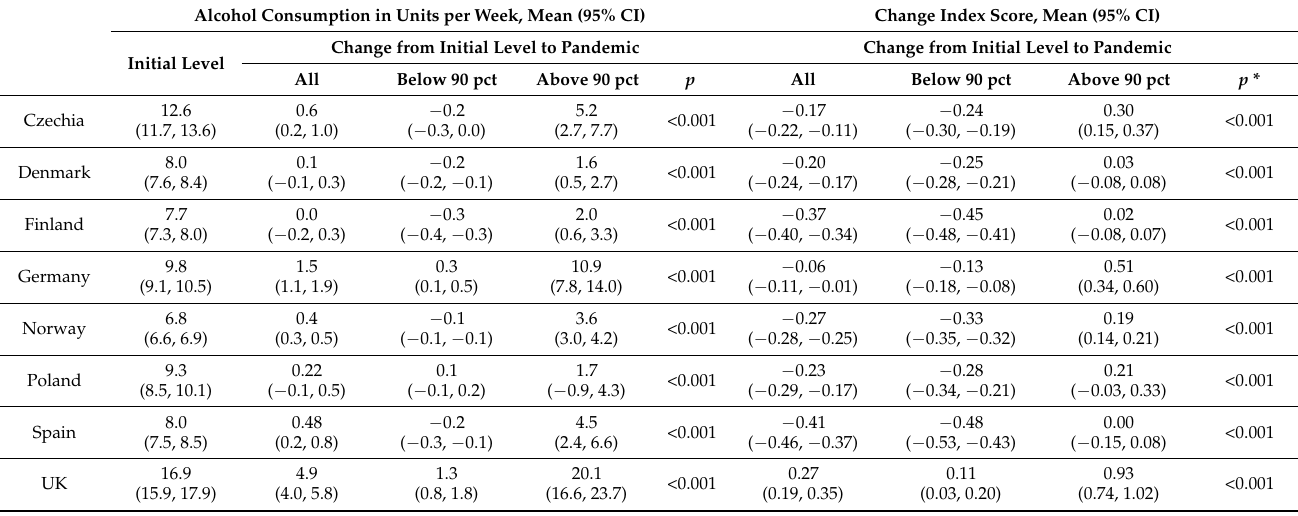
Table 2. Initial consumption, change in alcohol consumption for all and by initial consumption level (below vs. above 90th percentile), and change index score for all and by initial consumption level (below vs. above 90th percentile), by country. Alcohol Consumption in Units per Week, Mean (95% CI) Change Index Score, Mean (95% CI) Change from Initial Level to Pandemic Change from Initial Level to Pandemic Initial Level Below 90